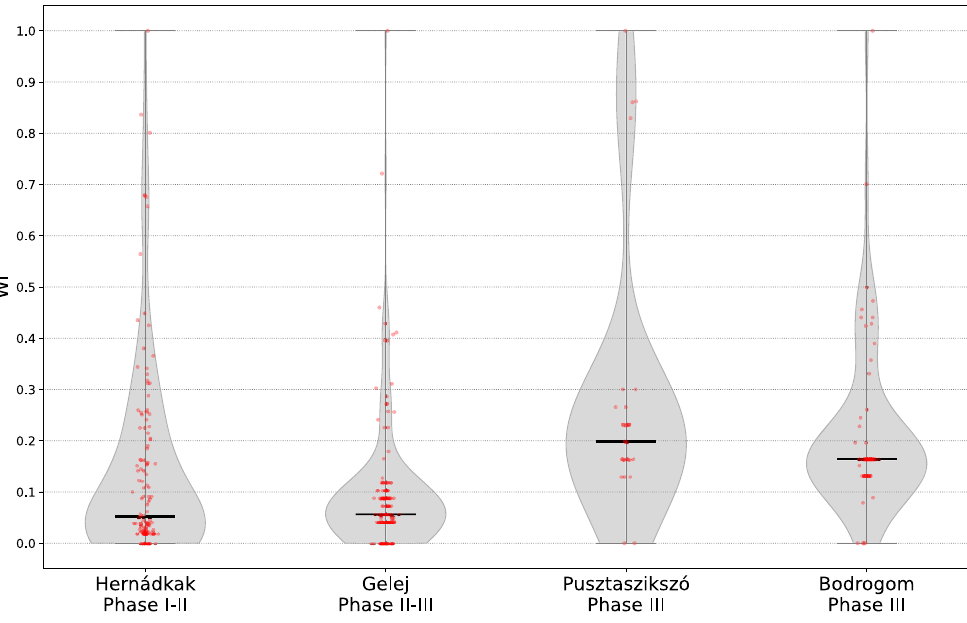
Figure 12: Comparison of the WI distribution of Füzesabony cemeteries Phase I to III ( c. 2200 – 1450 BCE ) . Bold black bars indicate the